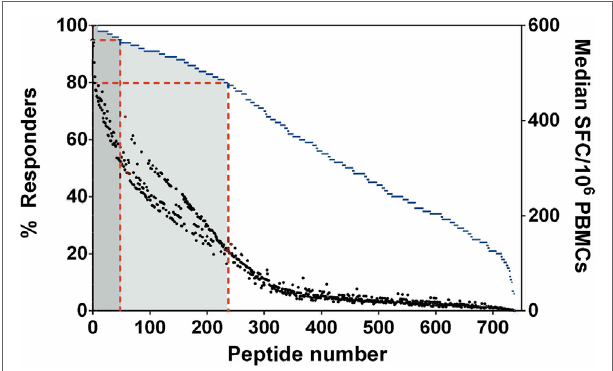
FigUre 1 | Immunoprevalent peptides identified using Burkholderia pseudomallei antigen peptide libraries in seropositive healthy donors. Peptides were ranked on the basis of % responders from highest to lowest, plotted on the left y -axis (blue dashed line represents % responders = total number of individuals that responded to a particular peptide/number of donors tested). Median spot forming cell (SFC)/10 6 peripheral mononuclear cell (PBMC) is plotted on the right y -axis (black dot represented for median SFC/10 6 PBMCs = sum of total SFC/number of donors tested). Red dashed lines indicate the 49 peptides which were recognized by ≥ 95% of all tested donors (dark gray zone), the 235 peptides which were recognized by ≥ 80% of all tested donors (light gray